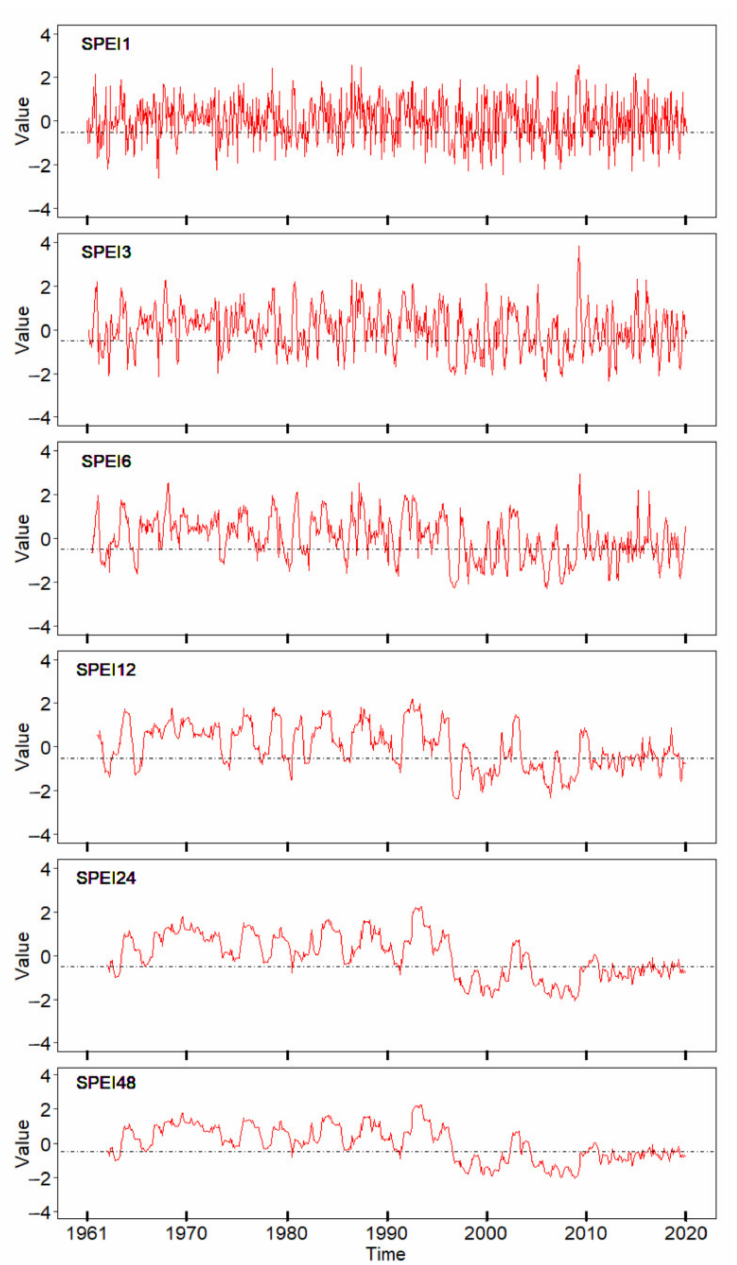
Figure 2. Different timescales of SPEI (1-, 3-, 6-, 12-, 24-, 48-month) for NWC during the historical period (1961–2020). The dotted line is the threshold level of −